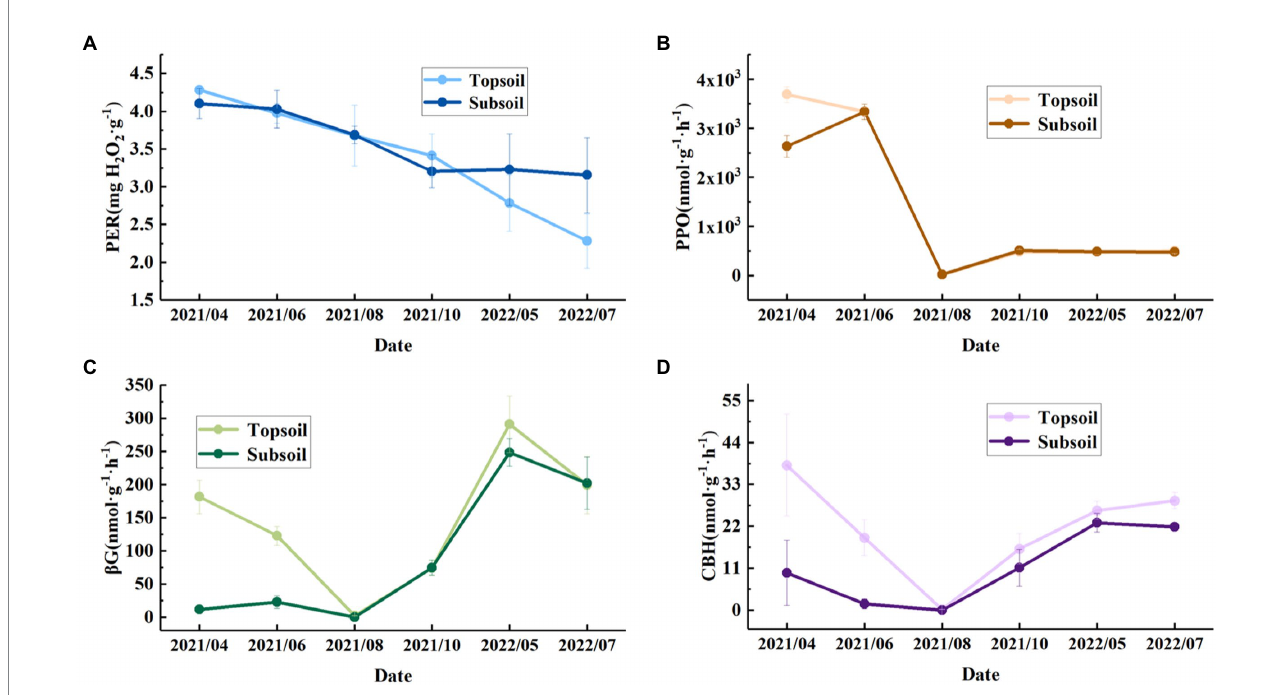
FIGURE 7 Monthly variations in enzyme activities in the topsoil (0–30 cm) and subsoil (30–100 cm) from April 2021 to July 2022. (A) PER, peroxidase. (B) PPO, polyphenol oxidase. (C) β G, β -1,4-glucosidase. (D) CBH,